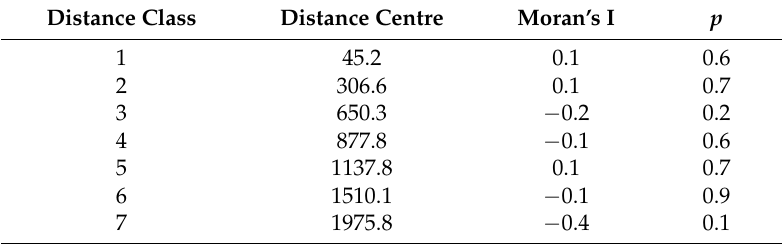
Table 3. Statistics for spatial autocorrelation analysis of L. duplicati infection levels in I. duplicatus populations at the 21 sites in